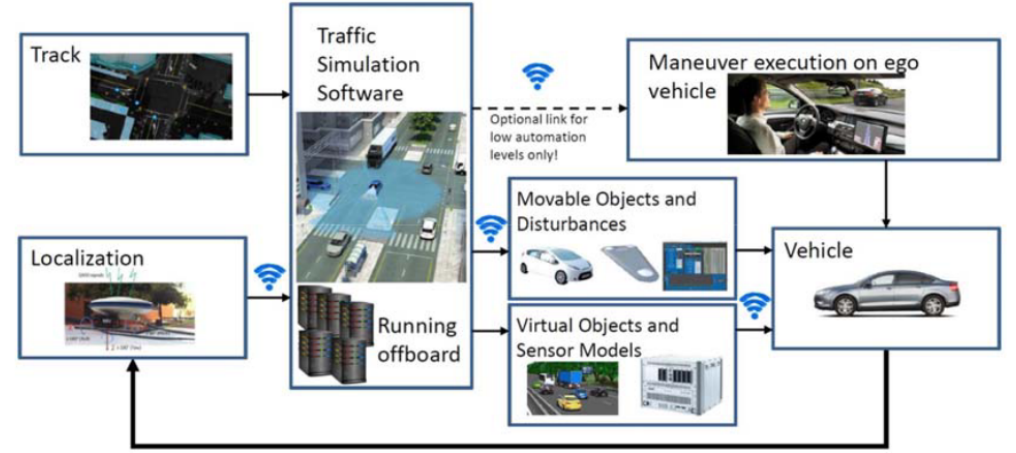
Figure 2. The Scenario-in-the-Loop (SciL) testing concept